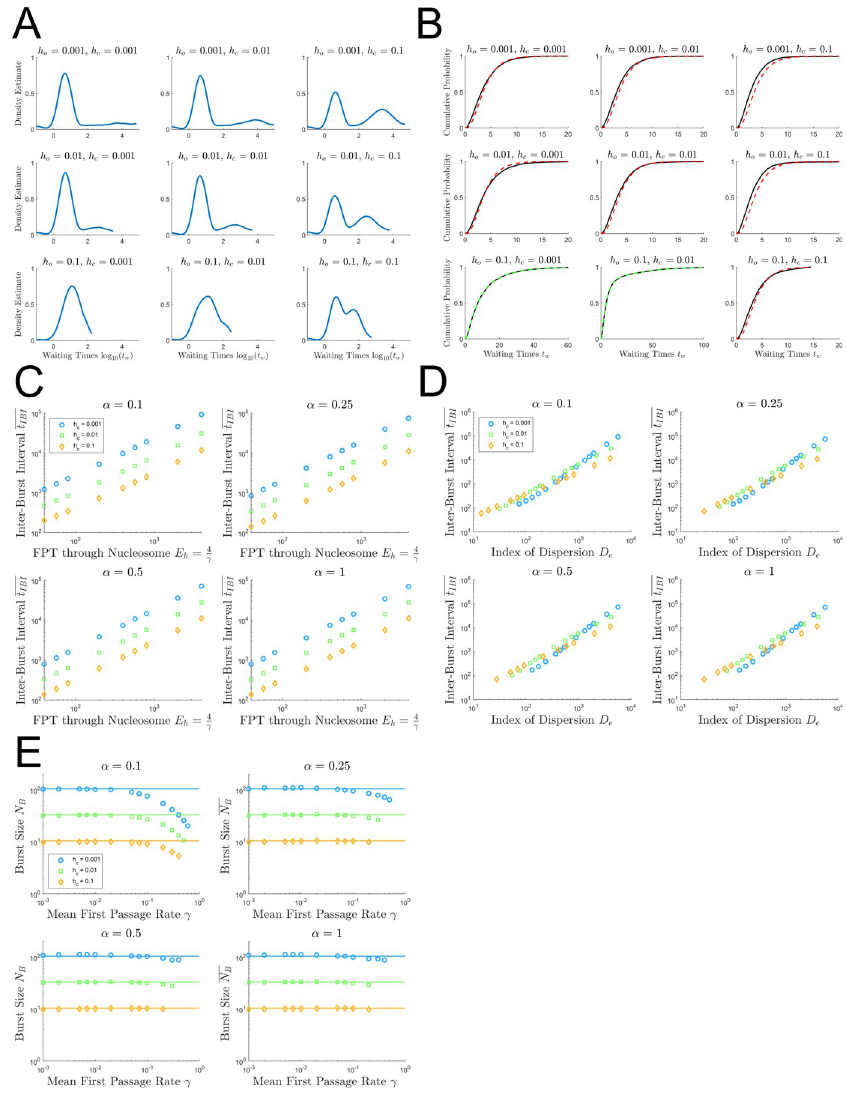
Fig 7. Investigation of the ddTASEP Inter-Burst Interval and Average Burst Size. (A) Representative smoothed kernel density estimates of log 10 ( t w ) weighted by log 10 ( t w ) using same parameter sets as Fig 2. (B) Empirical cumulative distribution functions of waiting times (black line) from ddTASEPs with the same parameters as in Fig 2. The time- headway cumulative distribution function is overlaid for each plot (Eq 42). The red dashed time headway distributions have robust bursting with an effective density ρ = 0.5. In contrast, the green dashed lines indicate initiation limited eff cases where unimodality was observed in Fig 7A, and ρ is given by Eq 39. (C) shows the average inter-burst interval t IBI plotted as a function of E h = 4/ γ . (D) shows the average inter-burst interval t plotted as a function of index of IBI dispersion of the first passage time to enter a nucleosome D . (E) shows burst size N plotted as a function of mean first e B p . Panels (C), (D), and (E) were generated with Fig 5A–5C. γ is passage rate γ with the solid lines proportional to 1 ffiffiffi h c varied from 0.001 to 0.99 by adjusting h o for fixed values of h c equal to 0.001 (blue), 0.01 (green), and 0.1 (orange) omitting cases that failed to show